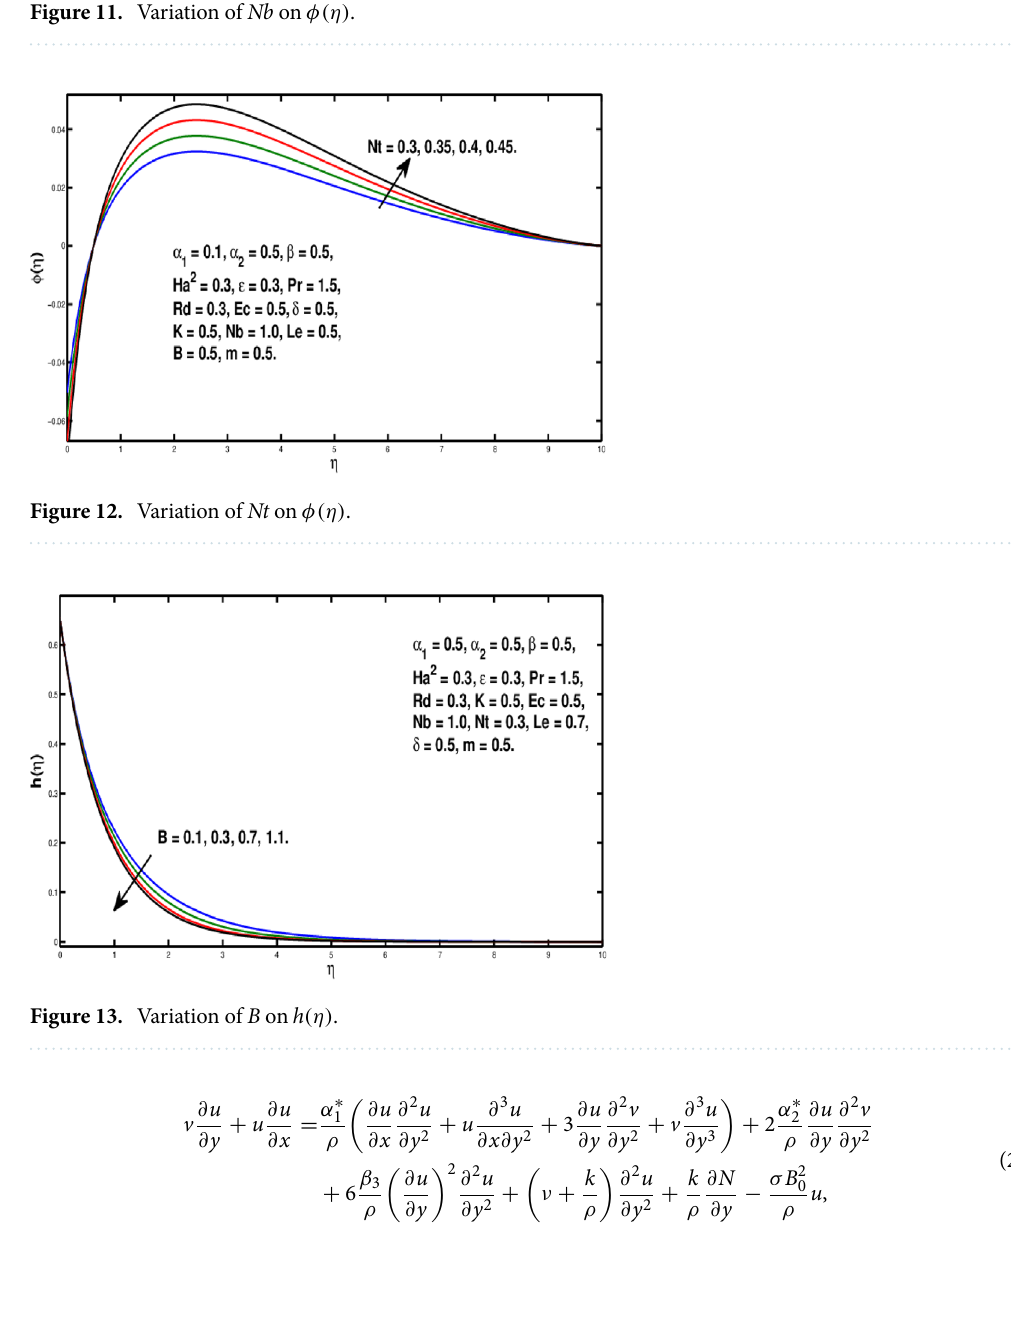
Figure 11. Variation of Nb on φ(η) .